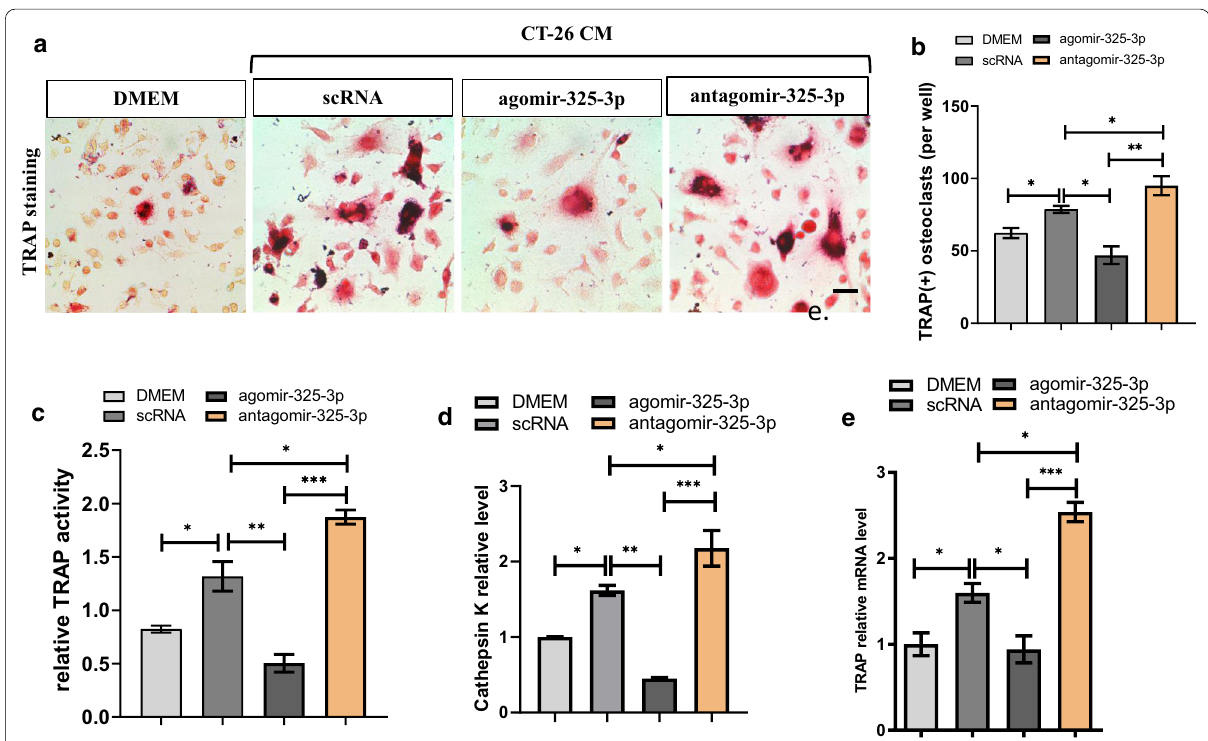
Fig. 2 miR-325-3p regulates CRC stimulated osteoclastogenesis. a OCPs were isolated through FACS and maintained in DEME or CT-26 CM and transfected with agomir-325-3p, antagomir-325-3p or negative controls in the presence of RANKL and M-CSF for 4 days. TRAP positive multinucleated cells with more than three nuclei were counted as mature osteoclasts (Scar bar 10 μm). b Quantification of osteoclast number in = each group in ( a ) (mean SE). c Relative TRAP activity assay indicated the TRAP activity changes in each group in ( a ) (mean SE). d Real-time PCR ± ± analysis showed the mRNA levels of Cathepsin K in each group in ( a ) (mean SD). e Real-time PCR analysis showed the mRNA level of TRAP in each ± group in ( a ) (mean SD). In vitro experiments were performed at least 3 times. *p < 0.05, **p < 0.01, ***p < ±